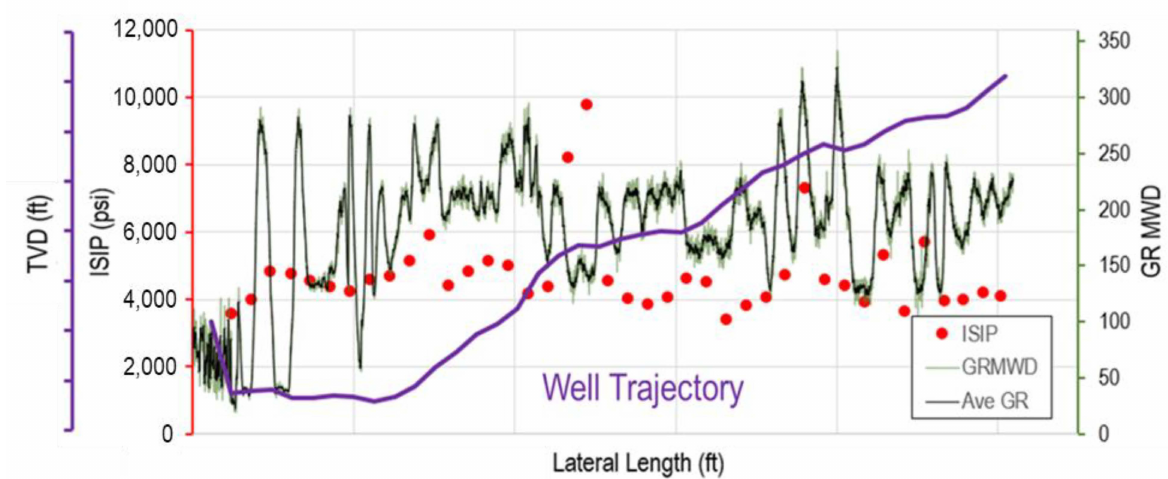
Figure 22. Gamma-ray measured while drilling and ISIP values variation along the lateral in Well #1, the purple line is the well